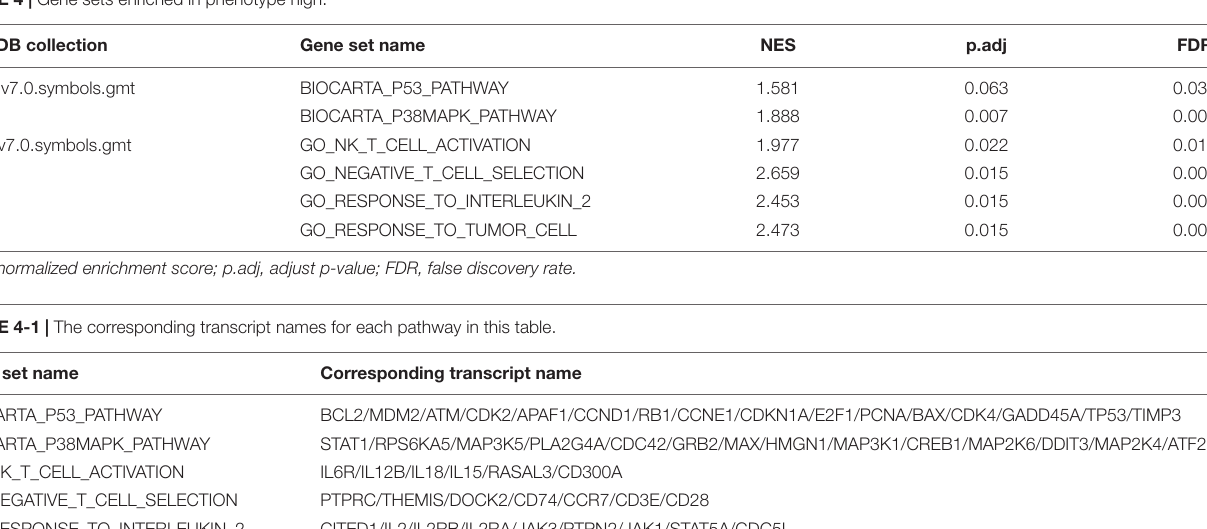
TABLE 4 | Gene sets enriched in phenotype high.